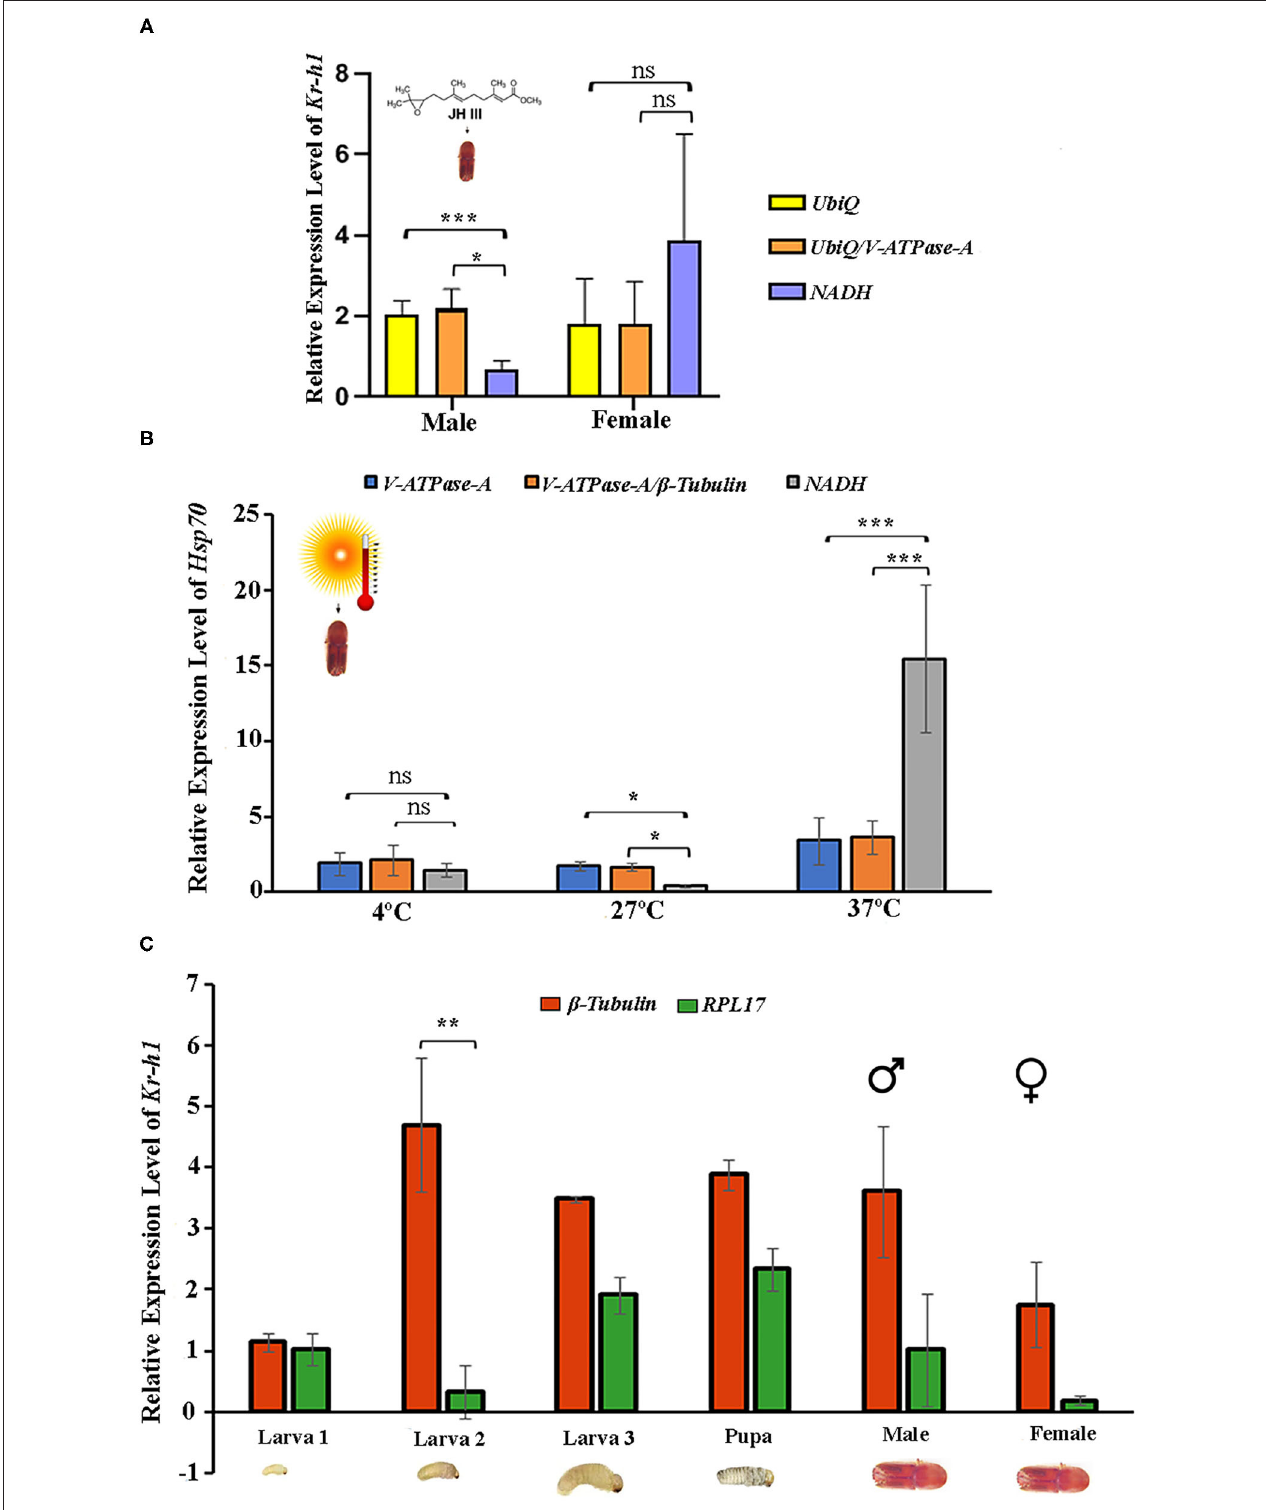
FIGURE 5 | Validation of the recommended reference genes. The relative expression levels of the target genes Kr-h1 and Hsp70 were studied under Juvenile hormone III treatment and temperature treatment by normalizing the selected reference gene. The most stable reference gene is UbiQ and V- ATPase-A for